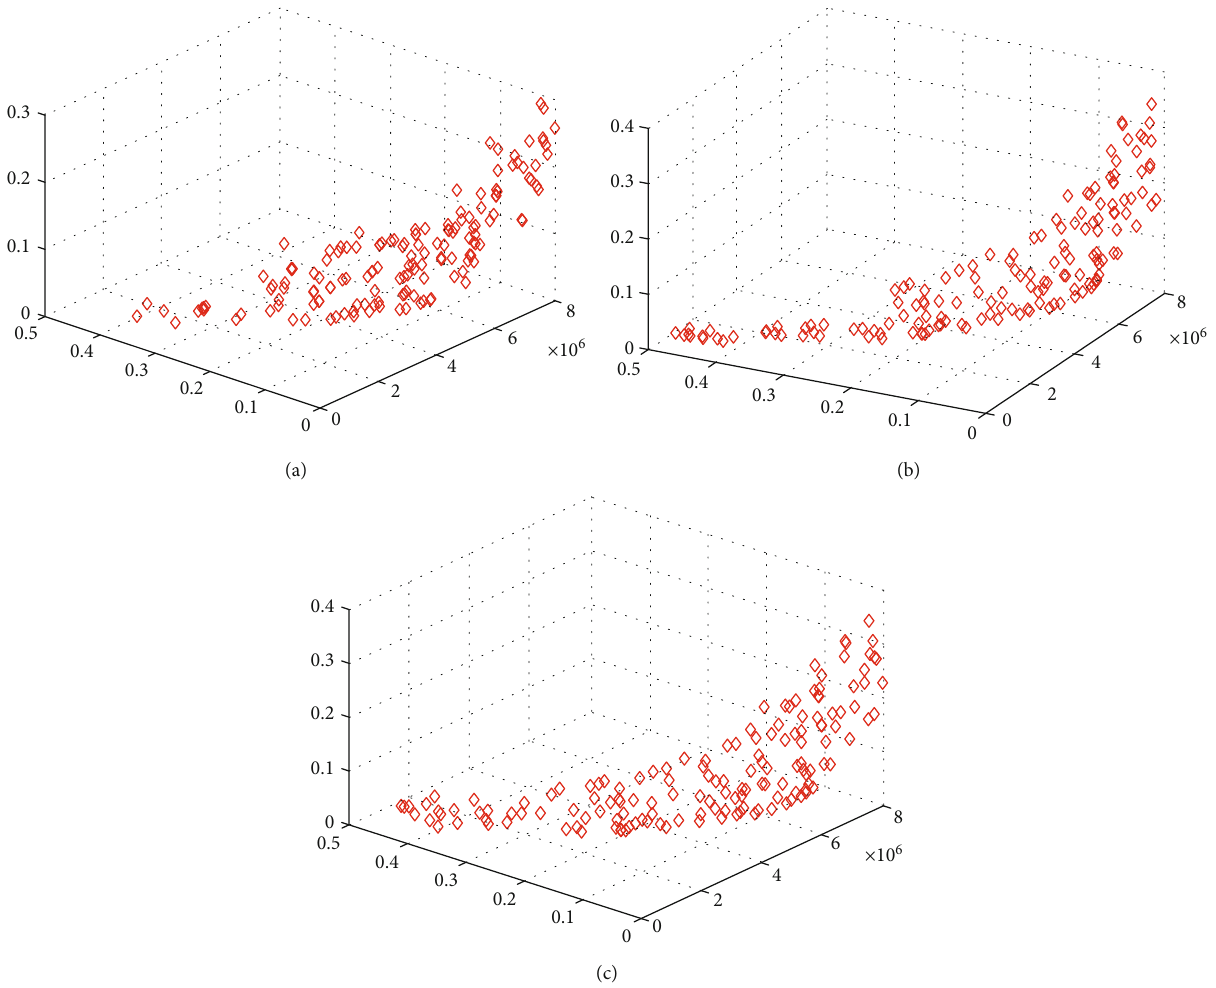
Figure 9: Paretooptimal fronts obtained by 3 algorithms. (a) NSGA-II optimization results. (b) MOGWO optimization results. (c) IMOGWO optimization